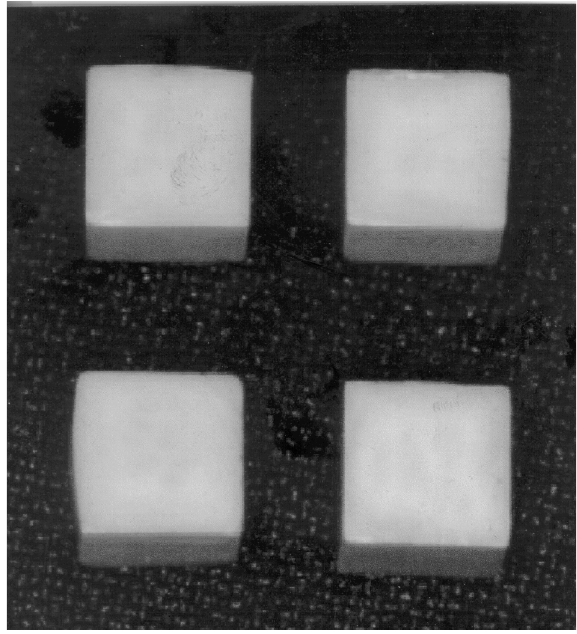
FIGURE 1- Glass-infiltrated alumina ceramic blocks (In-